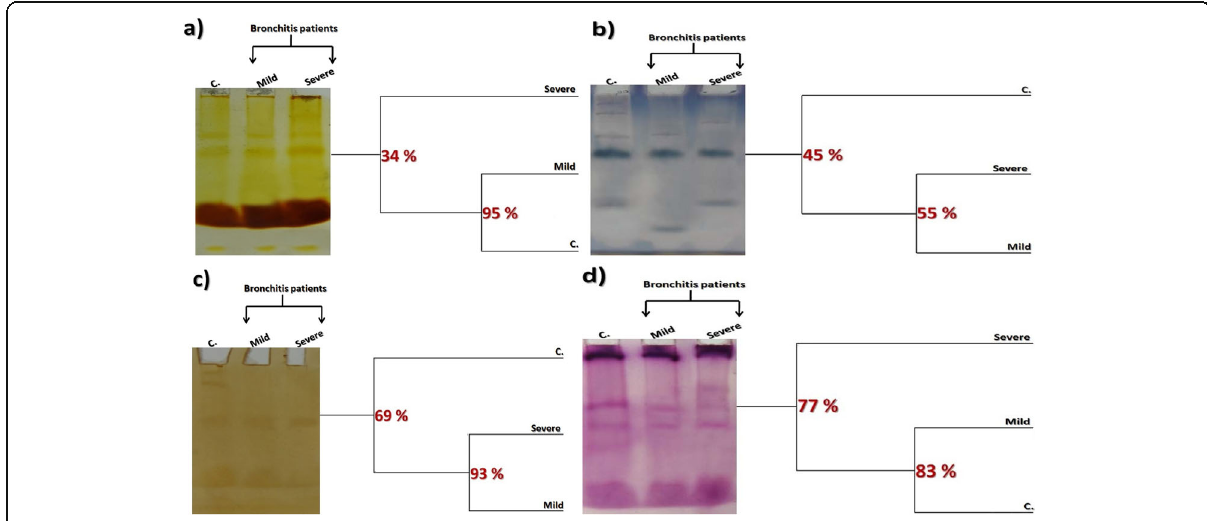
Fig. 3 Electrophoretic isoenzymes patterns showing the physiological variations in bands number, arrangement and similarity percent (SI%) in a ) Catalase (CAT, b ) Peroxidase (POX), c ) α -Esterase ( α -EST) and d ) β -Esterase ( β -EST) in asthmatic bronchitis patients at mild and sever stages as compared to control (healthy